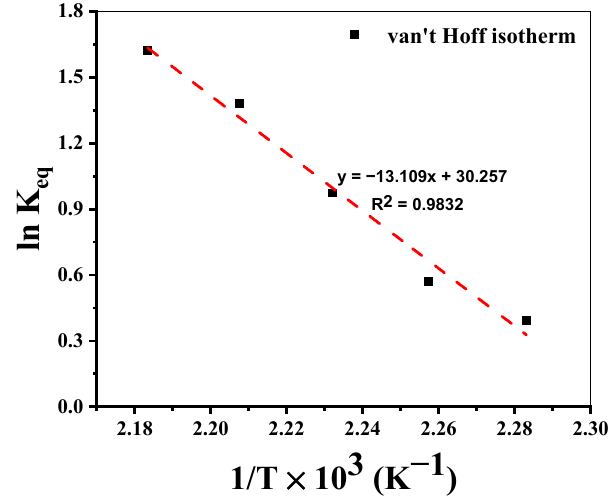
Figure 5. van’t Hoff plot for evaluation of thermodynamic parameters. The van’t Hoff plot shows a typical endothermic behavior. The reaction enthalpy calculated from the slope is ∆ H = 109 kJ/mol. An entropy calculated from the intercept is ∆ S = 252 J/mol . K. The ceiling temperature ( T C ) calculated from Equation (10) is found to be 160 ◦ C, for equilibrium reaction ∆ G R = 0. To validate this idea, at 150 ◦ C ( T < T C ), PET conversion of only 9% was achieved even after 6 h, indicating the necessity of T > Tc